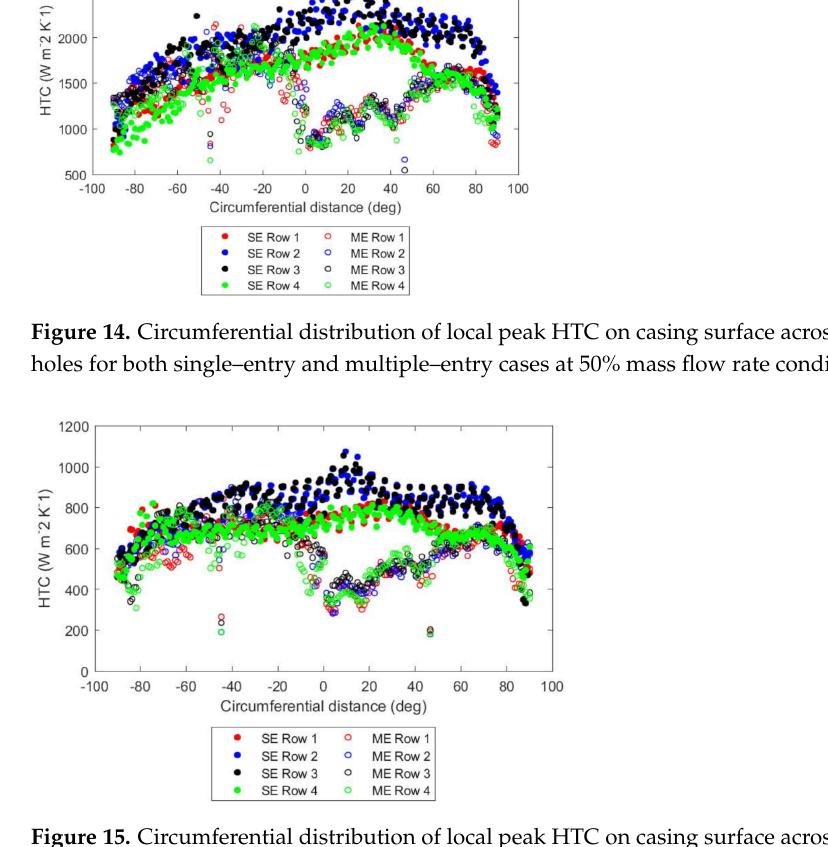
Figure 15. Circumferential distribution of local peak HTC on casing surface across all four arrays of holes for both single–entry and multiple–entry cases at 20% mass flow rate